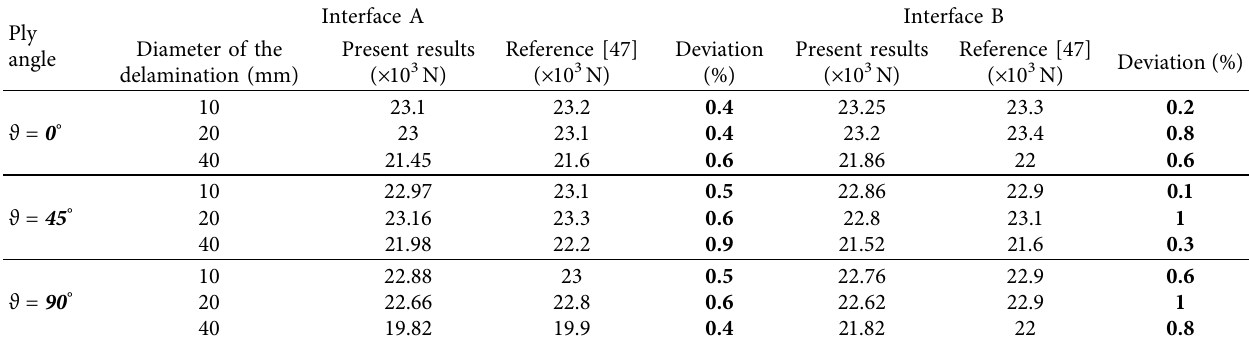
Table 5: Buckling loads of laminate containing initial circular delamination compared with